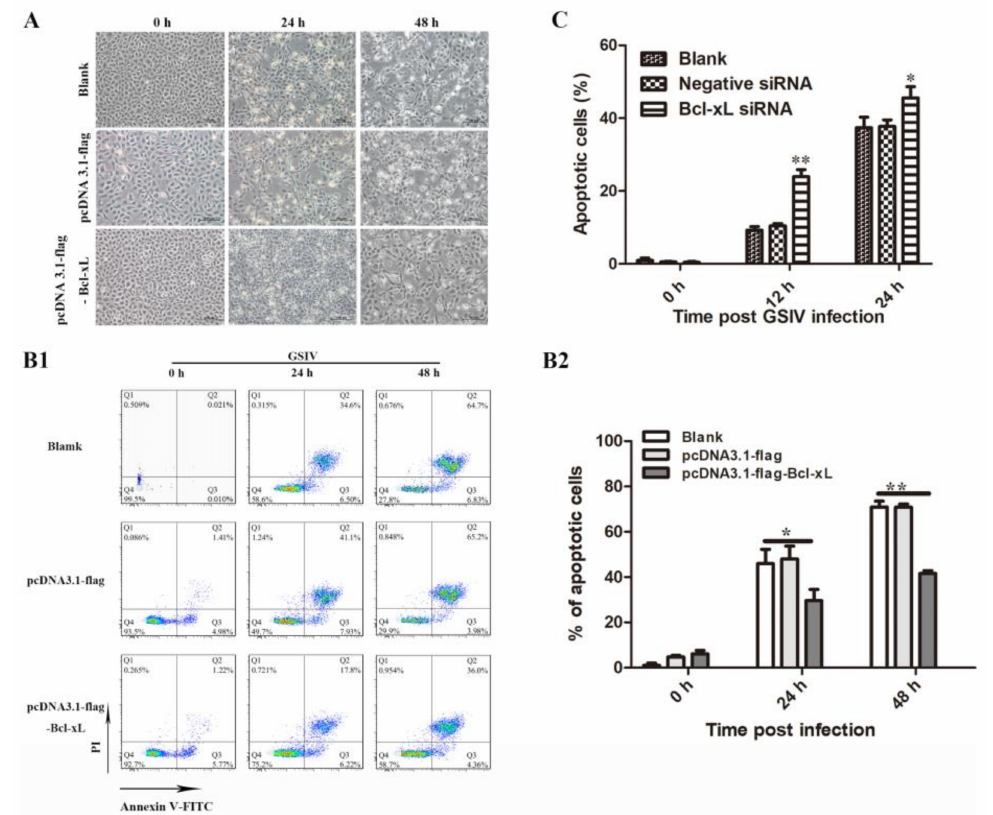
Figure 3. Morphological changes and apoptosis analysis of normal GSM cells, pCDNA3.1-flag transfected GSM cells and pCDNA3.1-flag-AdBcl-xL transfected GSM cells after infection with GSIV (MOI = 0.5). ( A ) Morphology and cytopathic effect (CPE) of normal GSM cells, and cells transfected with pCDNA3.1-flag or pCDNA3.1-flag-AdBcl-xL at 0, 24, and 48 h post GSIV infection. Scar bar, 100 µ m. ( B1 ) FACS analysis of normal GSM cells and GSM cells transfected with pCDNA3.1-flag or pCDNA3.1-flag-AdBcl-xL treated with GSIV and stained with Annexin V-FITC and PI. ( B2 ) Apoptosis rate of normal GSM cells and cells transfected with pCDNA3.1-flag or pCDNA3.1-flag-AdBcl-xL during GSIV infection. ( C ) Apoptosis rate of cells transfected with the negative control siRNA, cells transfected with AdBcl-xL-siRNA and normal cells. Error bars represent the mean ± SD; * p < 0.05, ** p < 0.01. All data shown are reproducible and representative of three independent